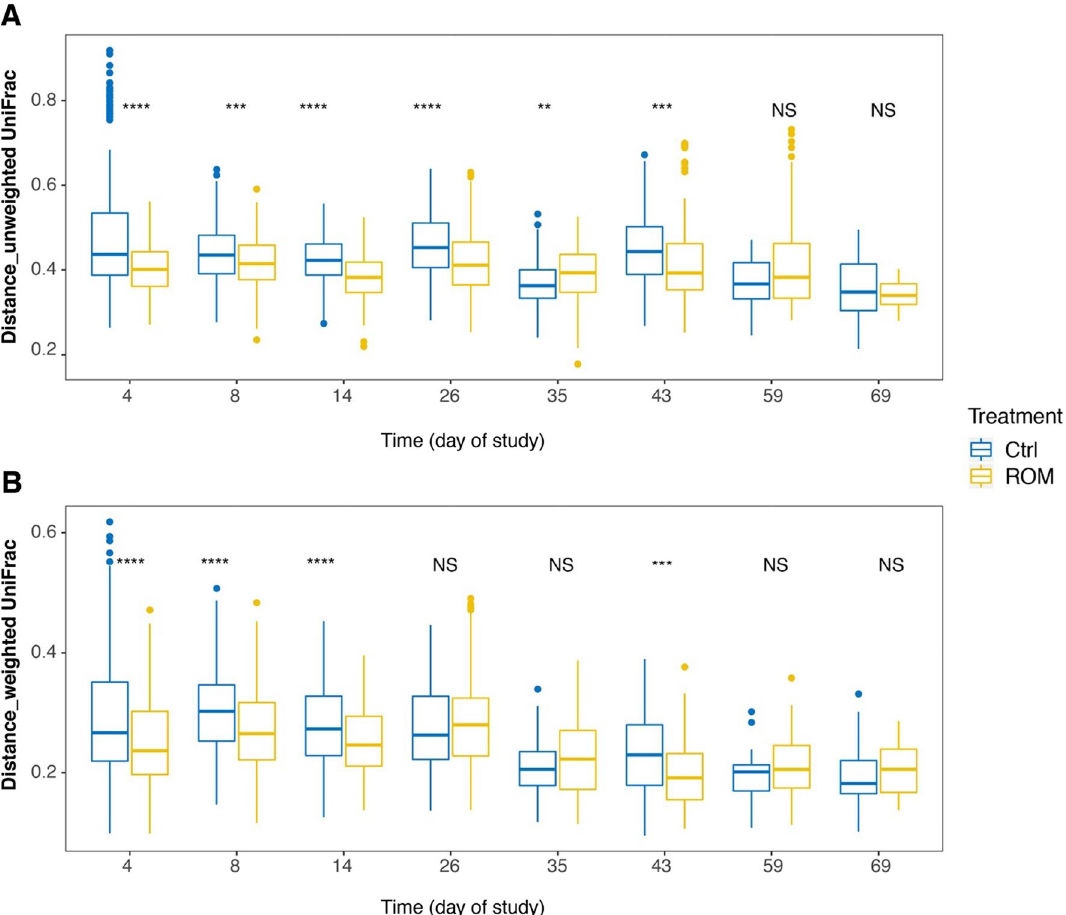
Fig. 2 The effect of ROM treatment on faecal microbial inter‑individual variation. Boxplots show the inter‑individual variation for ROM versus Ctrl pigs in faecal microbial composition over time based on unweighted ( A ) and weighted ( B ) UniFrac distances. Significance between treatments was assessed by Wilcoxon rank sum test per time point. Asterisks are used to indicate the statistical differences between treatments (** p < 0.01, *** p < 0.001, **** p < 0.0001). Blue and yellow colours represent control (Ctrl) and treated (ROM) groups,